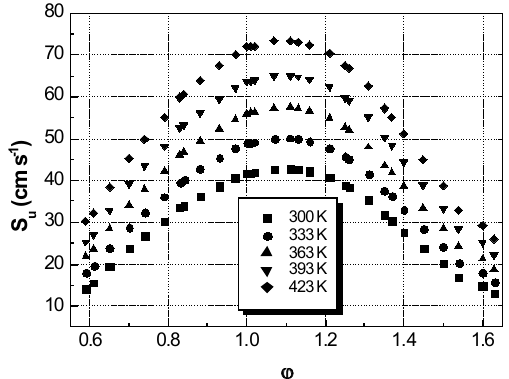
Figure 2. Computed burning velocities of ethane-air mixtures at 1 bar and various initial temperatures.